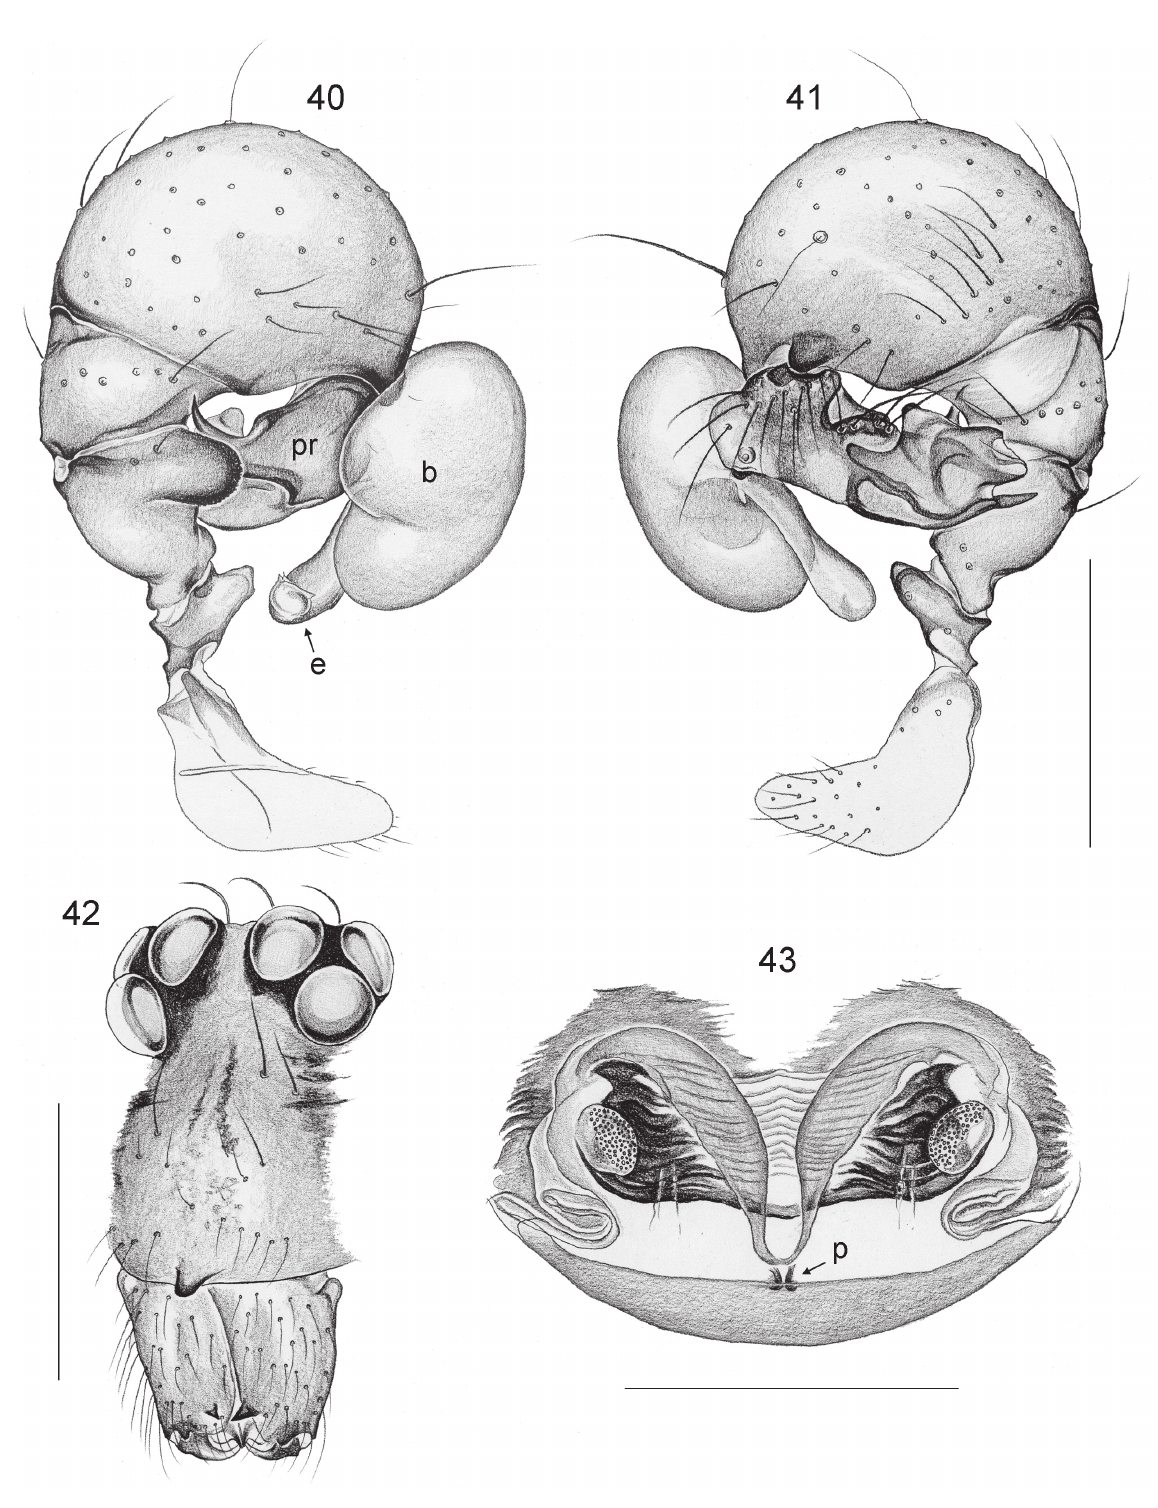
Figs 40-43. Anansus kamwai sp. nov. 40-41 . Left ♂ palp, prolateral and retrolateral views. 42 . ♂ ocular area, clypeus and chelicerae, oblique frontal view. 43 . Cleared ♀ genitalia, dorsal view. b = bulb; e = embolus; p = pocket; pr = procursus. Scale lines: 0.3